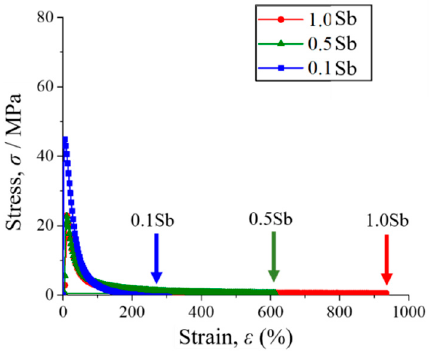
Figure 6. Stress–strain curves of Sn-40Bi-0.1Sb under various strain rates at ( a ) 298 and ( b ) 353 K.